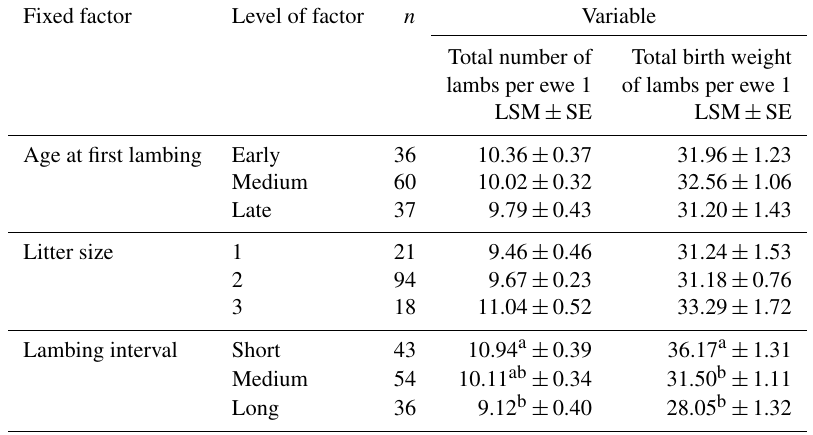
Table 2. Analysis of variance results of the total number of lambs per ewe 1 and total birth weight of lambs per ewe 1. Fixed factor